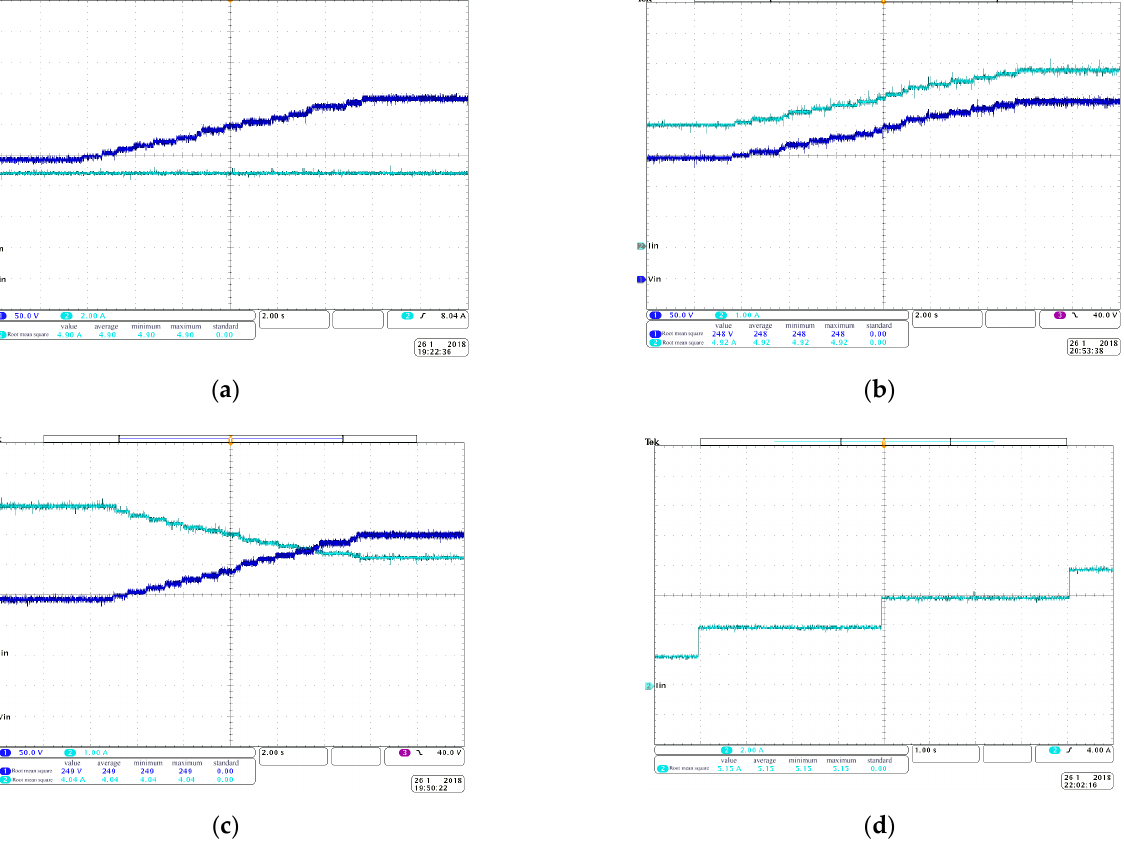
Figure 11. Load simulation function test. ( a ) Constant I function test; ( b ) constant R function test; ( c ) constant P function test; ( d ) variable load function test.